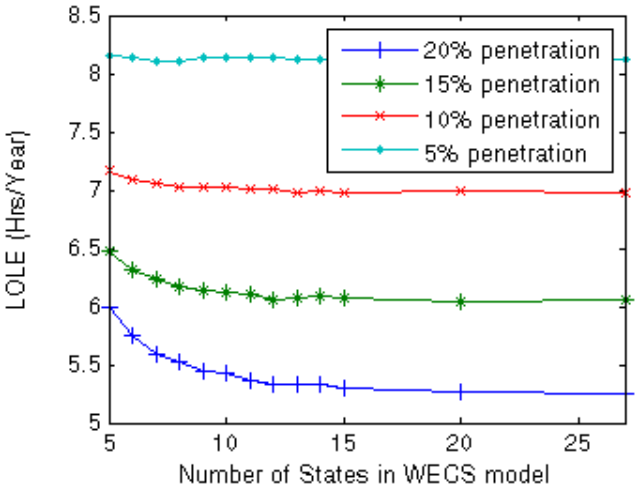
Figure 9. Variation in LOLE results with the NoS in the wind model at different wind